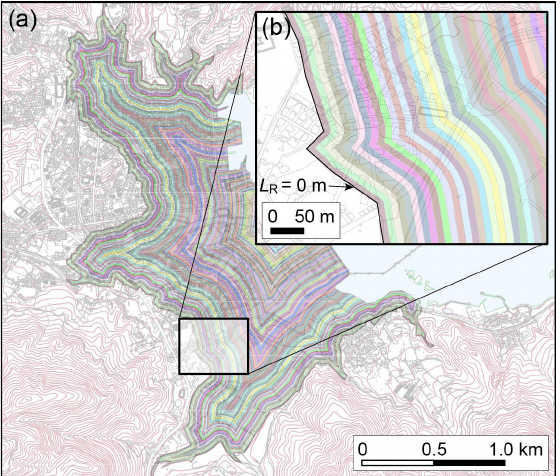
Figure 16. ( a ) Ten-meter-wide belt transects from the inundation boundary to the shoreline in Owase City. ( b ) A portion of the inundated area showing belt transects in relation to the tsunami inundation boundary ( L R = 0